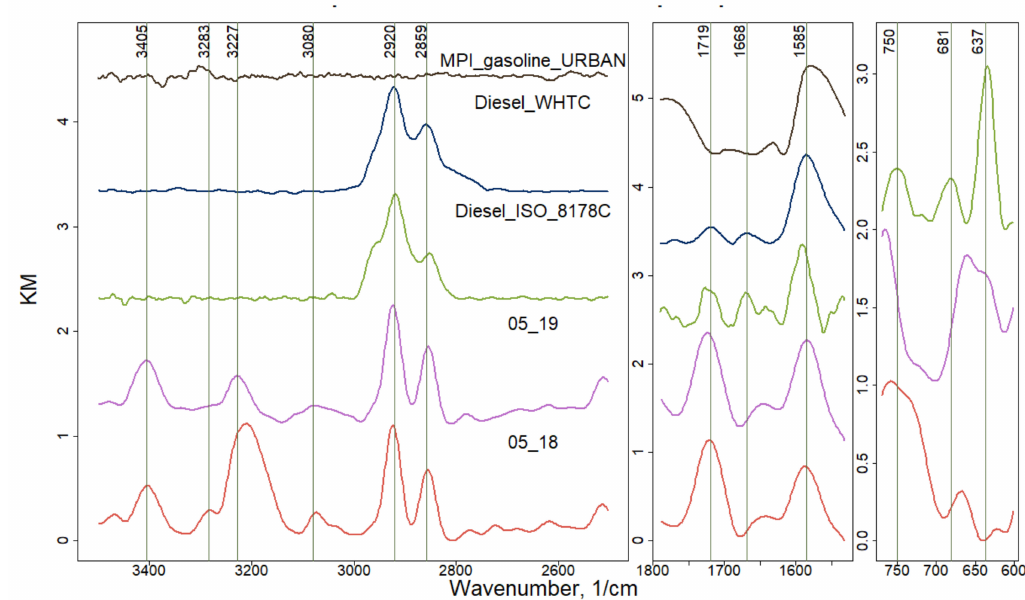
Figure 5. FTIR spectra for 05.18 and 05.19 from the FF period. Spectra of a heavy-duty diesel engine operated in the World Harmonized Transient Cycle and with conventional EN 590 diesel fuel engine (Diesel_WHTC), an o ff -road diesel engine operated in a Non-Road Steady State cycle ISO-8178 (Diesel_ ISO_8178), and an multi-point injection (MPI) gasoline engine operated in an Urban cycle (MPI_gasoline_URBAN) represent road and o ff -road diesel and gasoline emissions,